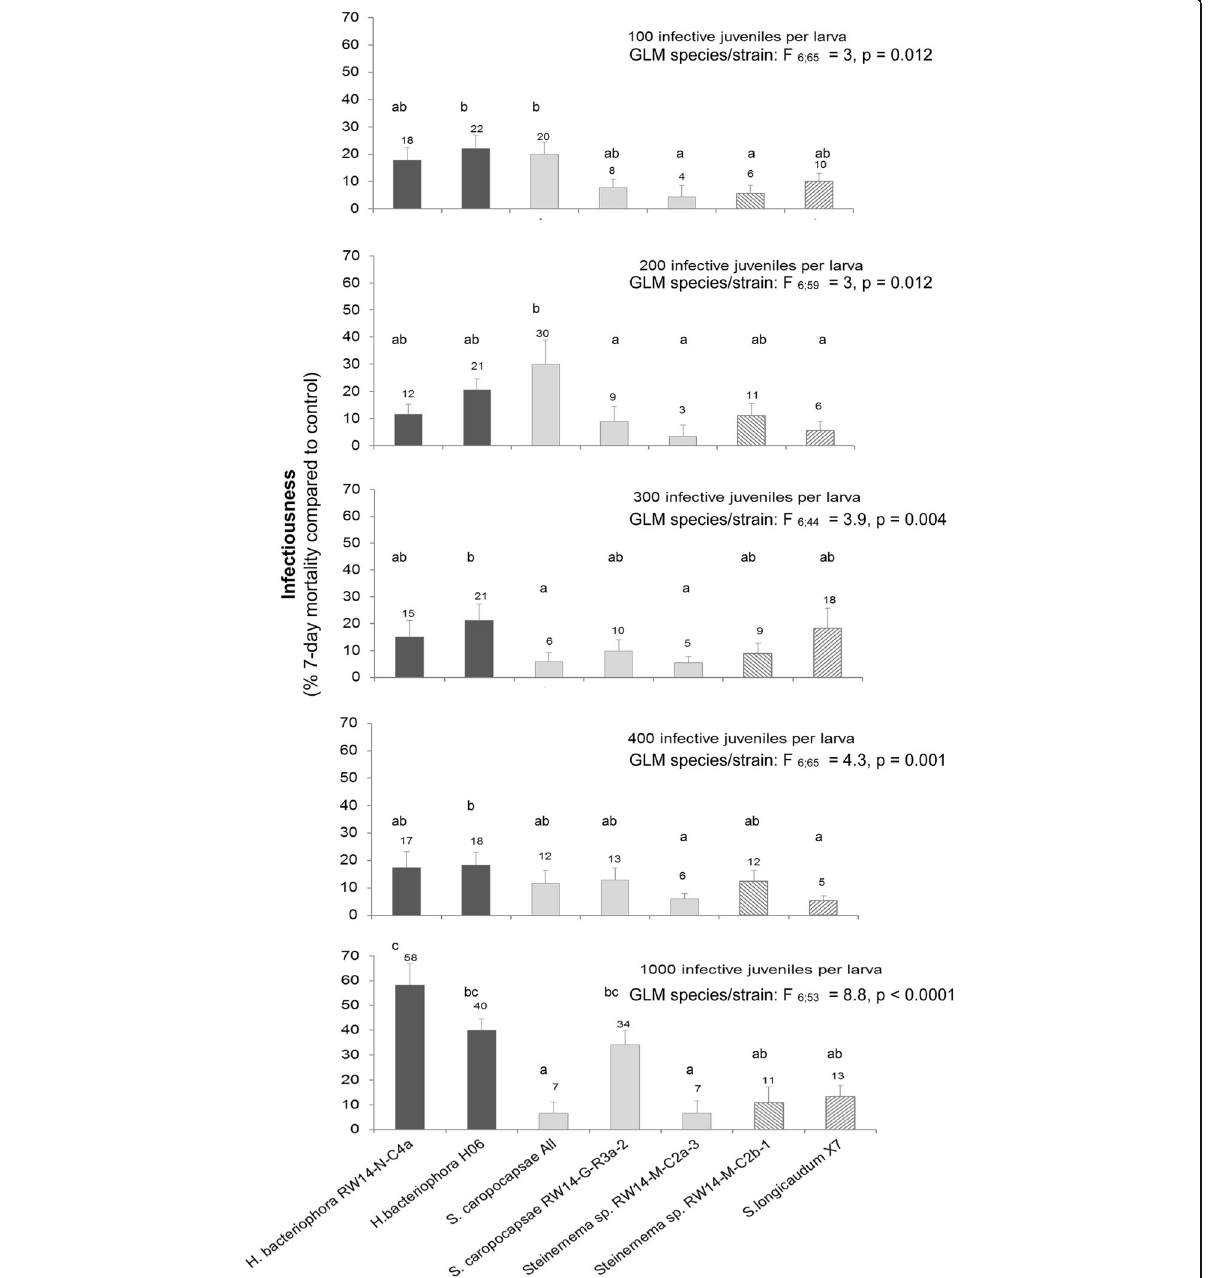
Fig. 2 Comparing the infectiousness of Rwandan (RW) and international entomopathogenic nematodes on Anomala graueri grubs in soil-based laboratory bioassays, depending on species/strain and on applied concentrations of 100, 200, 300, 400 and 1000 infective juveniles per grub equalling 14, 28, 42, 57 and 140 IJs per square centimetre soil. Dark grey bars = heterorhabdits, light grey = steinernematids, lined = verified in field trials (Figs. 4 and 5.); 7-day-corrected morality shown, this is mortality in EPN treatments minus natural mortality in untreated controls. Three sets of 10 bioassay arenas with single grubs in soil used per each of 3 to 15 experimental replicates; letters on bars indicate difference according to multiple comparison Tukey post hoc test at p < 0.05, additionally fdr-corrected among concentration experiments; error bars =